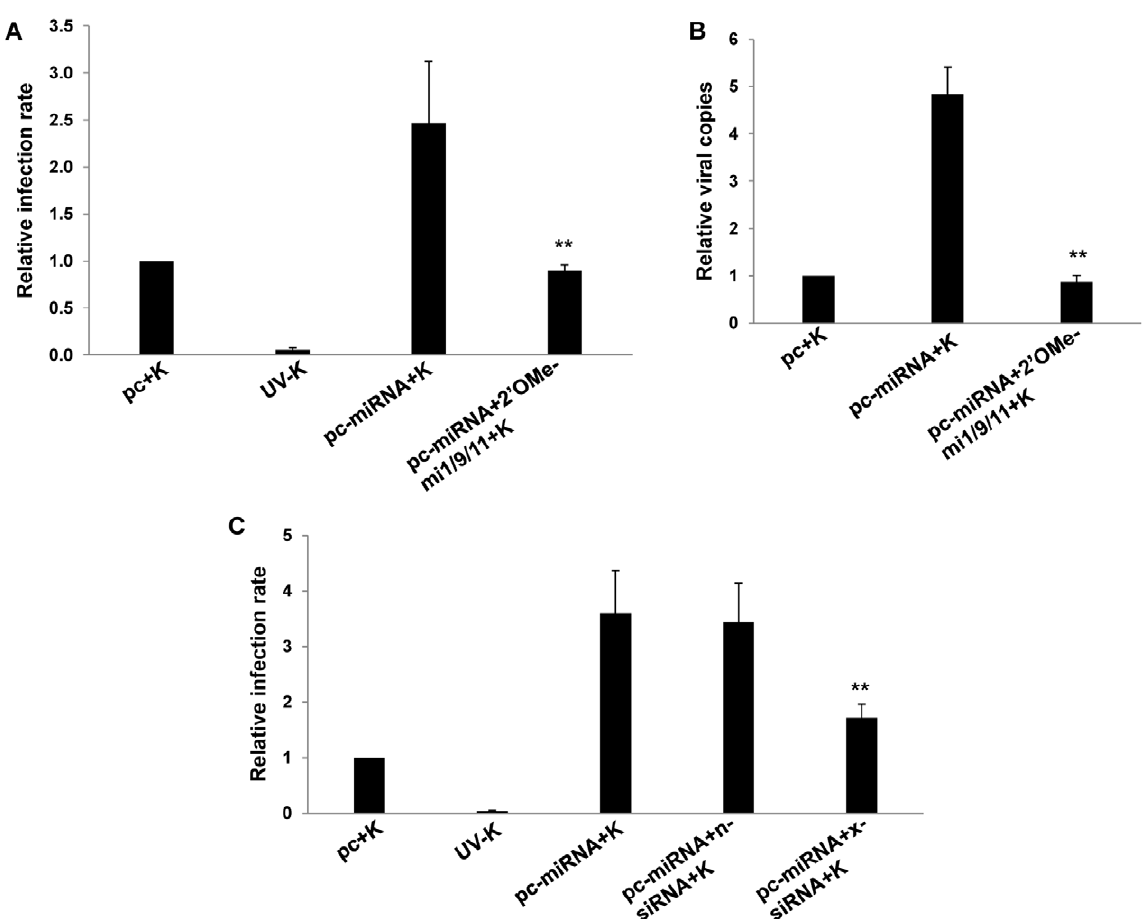
Figure 3. KSHV miRNA upregulation of xCT increases macrophage susceptibility to KSHV infection. ( A ) RAW cells were transfected with control or miRNA-expressing vectors then incubated with purified KSHV (K). LANA IFA were performed 16 h later, and relative infection rates were determined as outlined in Methods. ( B ) qPCR was used to determine relative intracellular KSHV DNA content for groups in A. ( C ) Cells were co- transfected with control or miRNA-expressing vectors and either control (n) or xCT-specific siRNA then incubated with purified KSHV. 16 h later, LANA IFA were used to determine relative infection rates. For all assays, error bars represent the S.E.M. for three independent experiments. * *=p ,